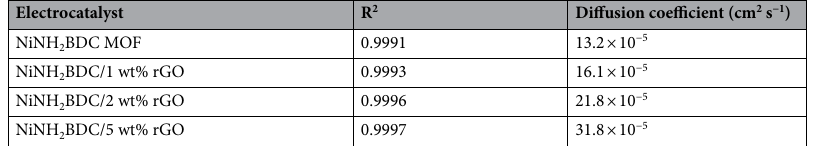
Table 1. The comparative statement of the magnitude of the diffusion coefficient and R 2 of NiNH 2 BDC MOF/1, 2, 5 wt% reduced graphitic carbon hybrids at 50 mV/s.